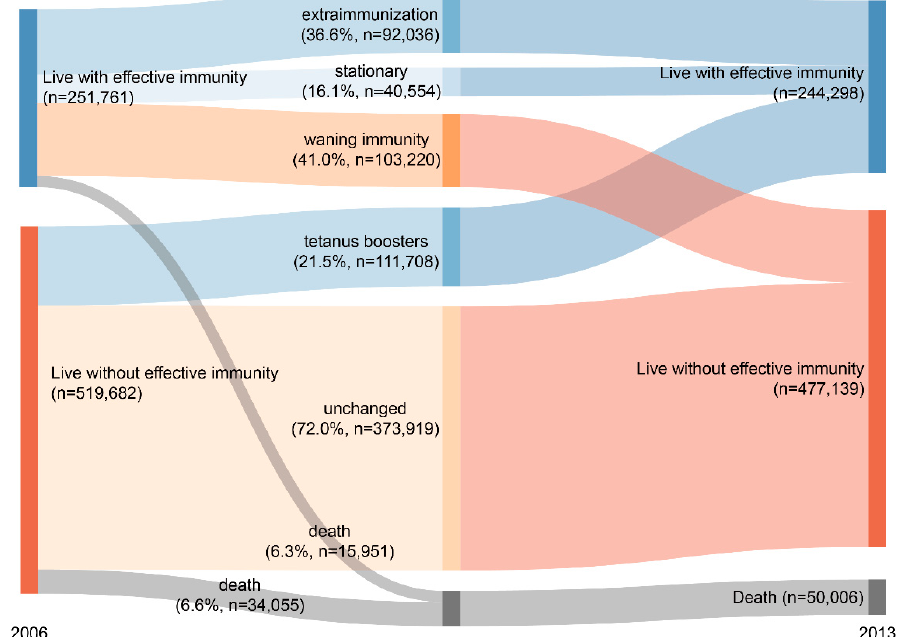
Figure 1. Interval change of immunity status against tetanus among adults aged between 20 and 79 years